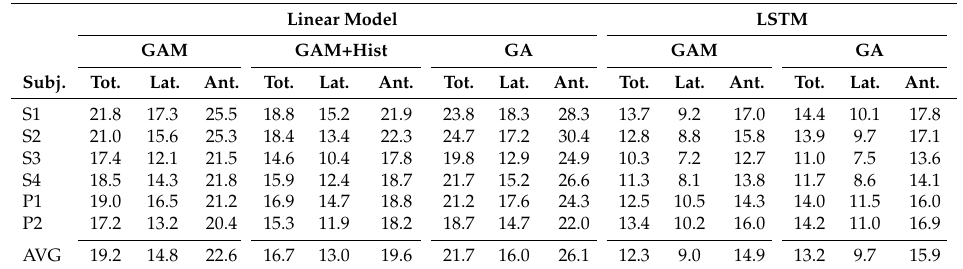
Table 4. Intra-subject test RMS error [mm] for the public dataset [26]. The total RMS error (Tot.) is split between the lateral (Lat.) and anterior (Ant.) components. Columns ‘GAM’ label models with the full input of gyroscope, accelerometer, and magnetometer data from all IMUs. Column ‘GAM+hist’ additionally includes the most recent 0.1s IMU data in the input. Linear Model LSTM GAM GAM+Hist GA GAM GA Subj. Tot. Lat. Ant. Tot. Lat. Ant. Tot. Lat. Ant. Tot. Lat. Ant. Tot. Lat. Ant.